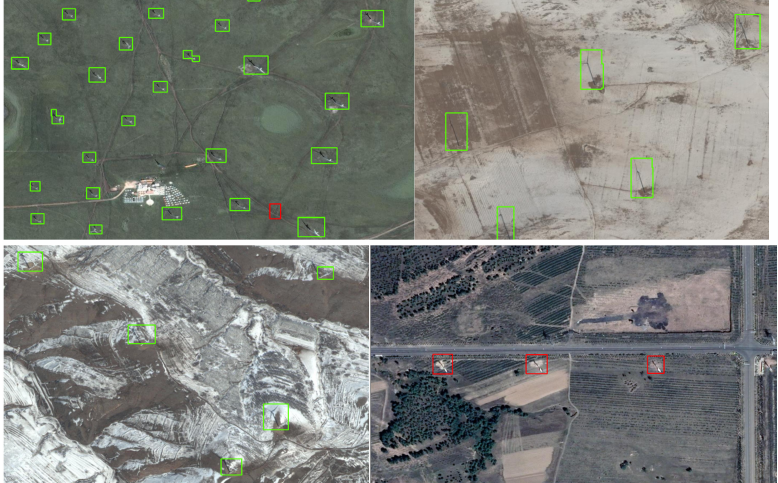
Figure 11. Typical object detection results. Green box means the right detection results; otherwise, the red box shows the wrong